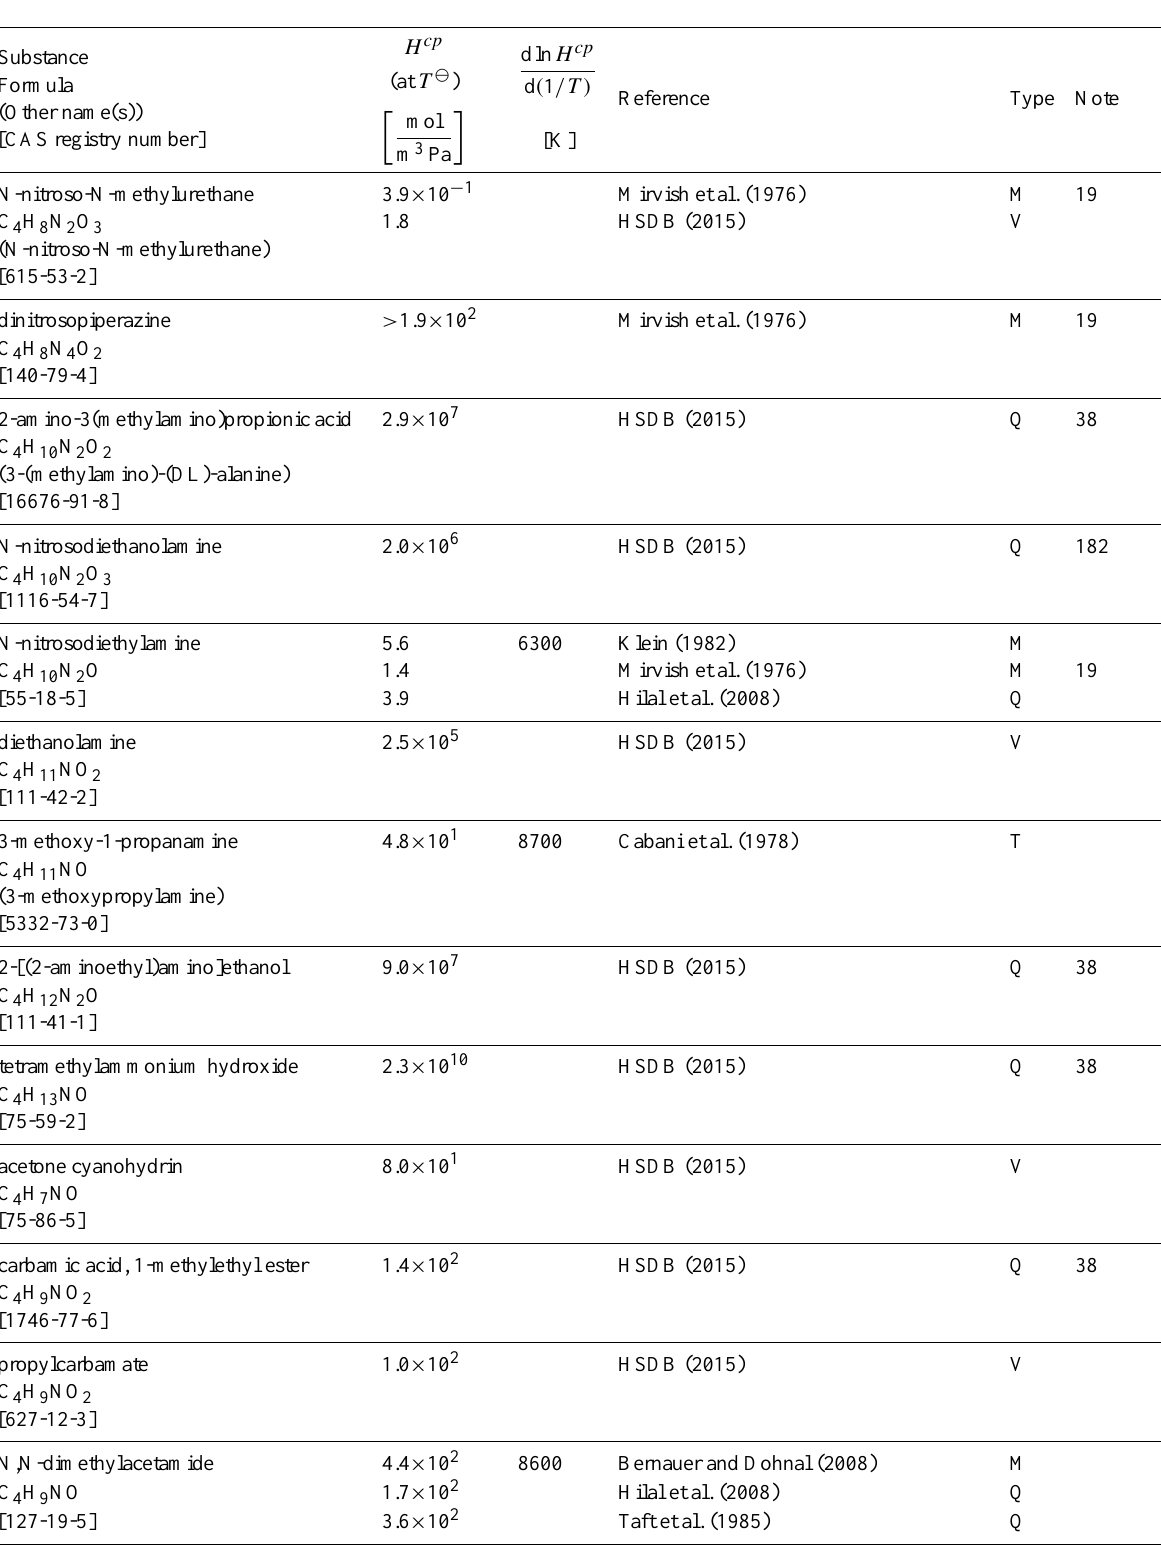
Table 6: Henry’s law constants for water as solvent